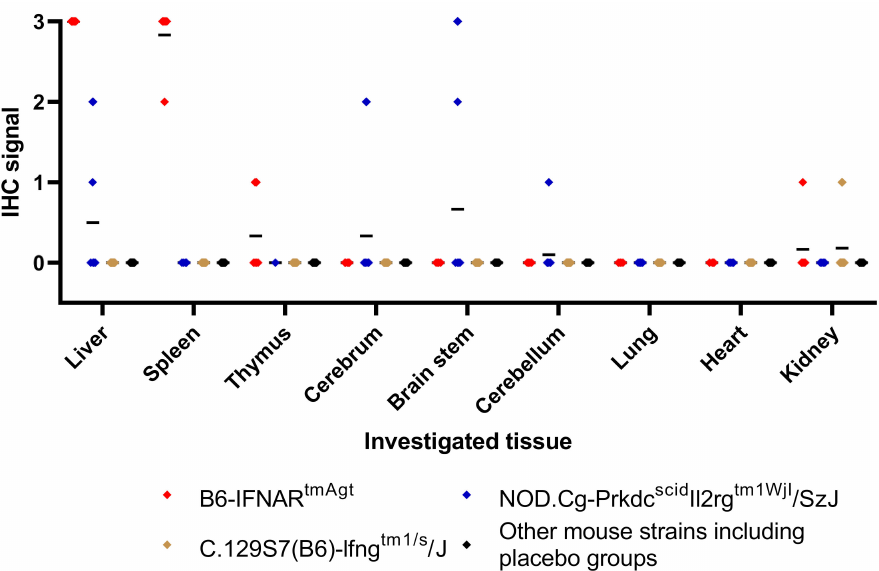
Figure 6. Graphic summary of the semi-quantitative immunohistochemistry evaluation: Each point represents one individual animal and mean values are given (black bars). While B6-IFNAR tmAgt mice exhibit high scores in liver and spleen, NOD.Cg-Prkdc scid Il2rg tm1WjI /SzJ mice show RVFV Np expression within the CNS in a subset of animals. Furthermore, a single C.129S7(B6)-Ifng tm1/s /J mouse exhibited viral antigen expression in the